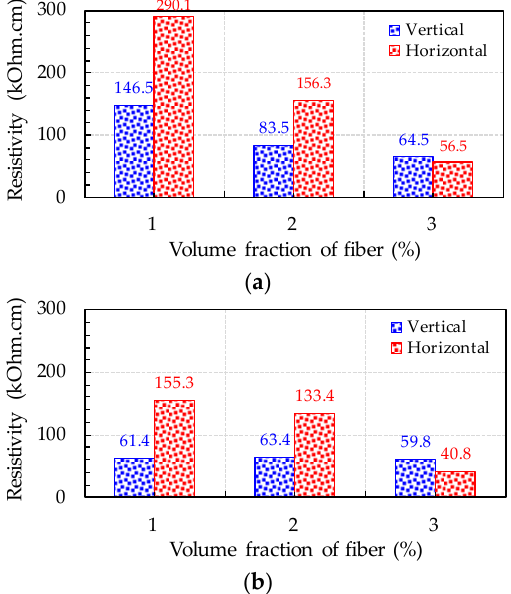
Figure 4. Effects of fiber volume fraction and orientation on the resistivity of UHPFRCs: ( a ) dried sample; and ( b ) ambient-cured sample (Note: Vertical, copper plates vertical to casting direction; and Horizontal, copper plates horizontal to casting direction).